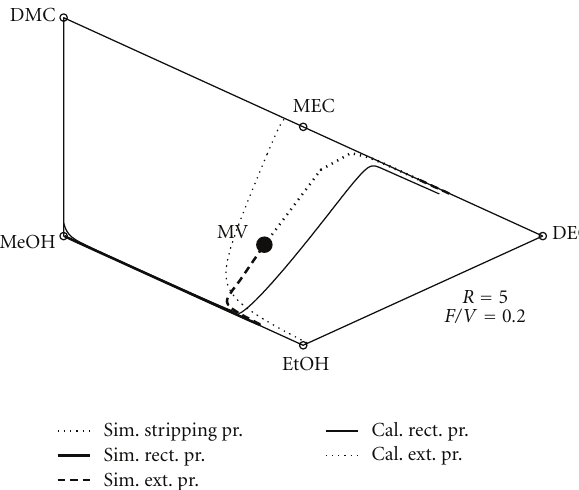
Figure 9: Simulated and calculated residue curves.